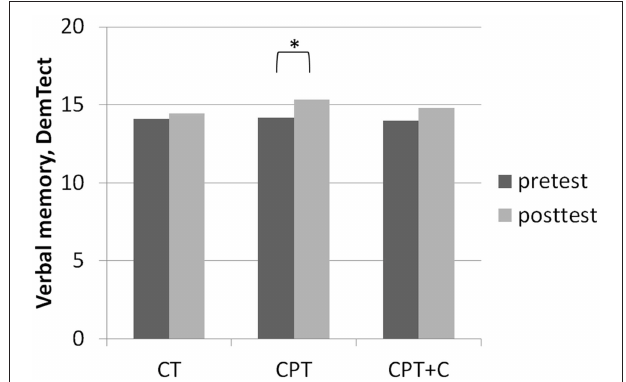
FIGURE 4 | Results of post-hoc analyses of within-subject factor Time for verbal memory assessed with the DemTect (Kalbe et al., 2004) in each training group separately. * p ≤ 0.05